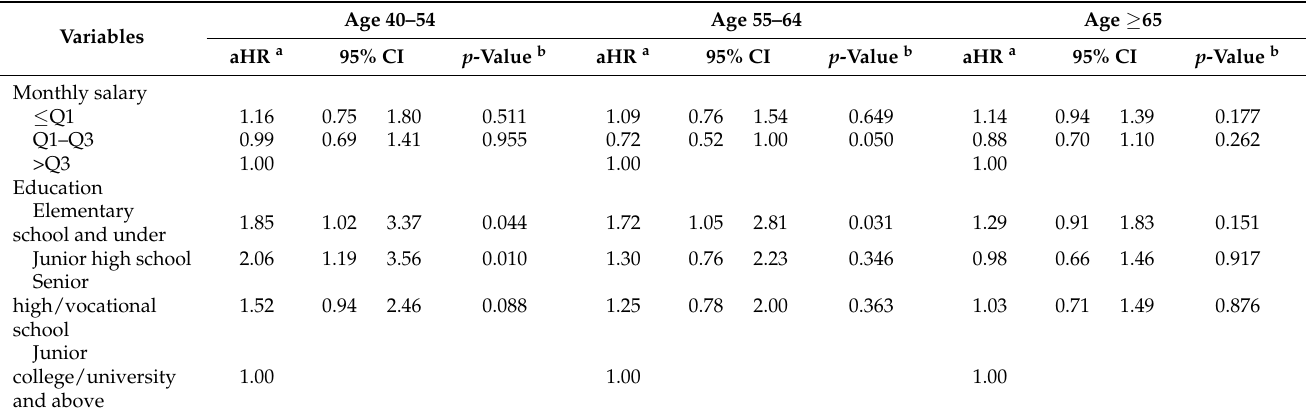
Table 6. Socioeconomic status associated with death risk of colorectal cancer patients stratified by age.